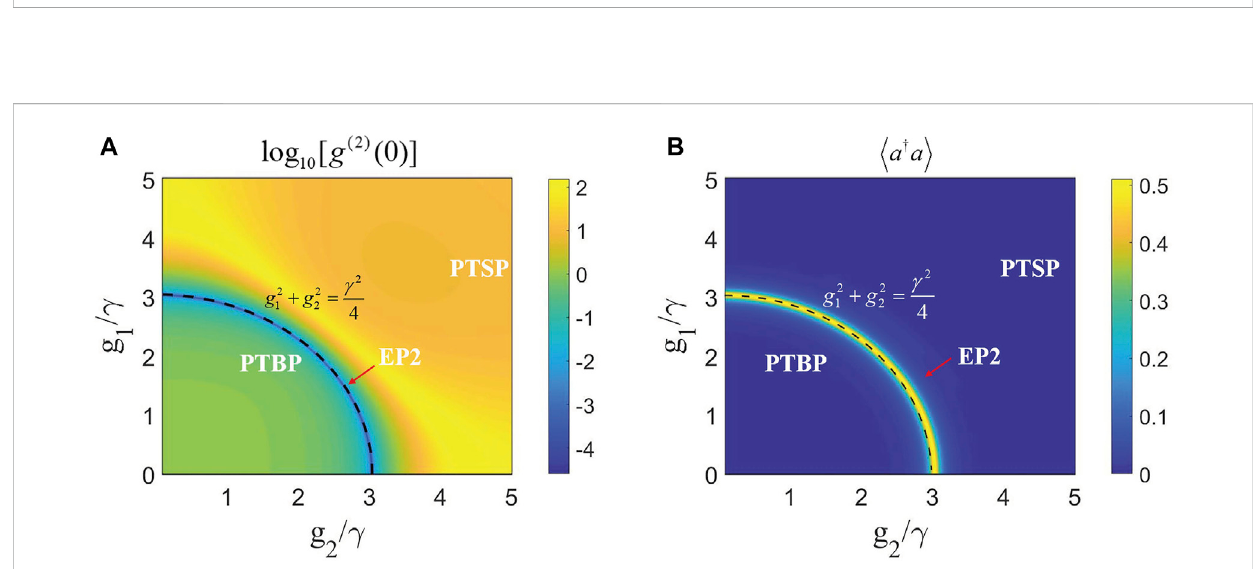
(cid:8) √ γ and Δ (cid:1) 0 , and the other parameters are same as those in the main text. 2 2